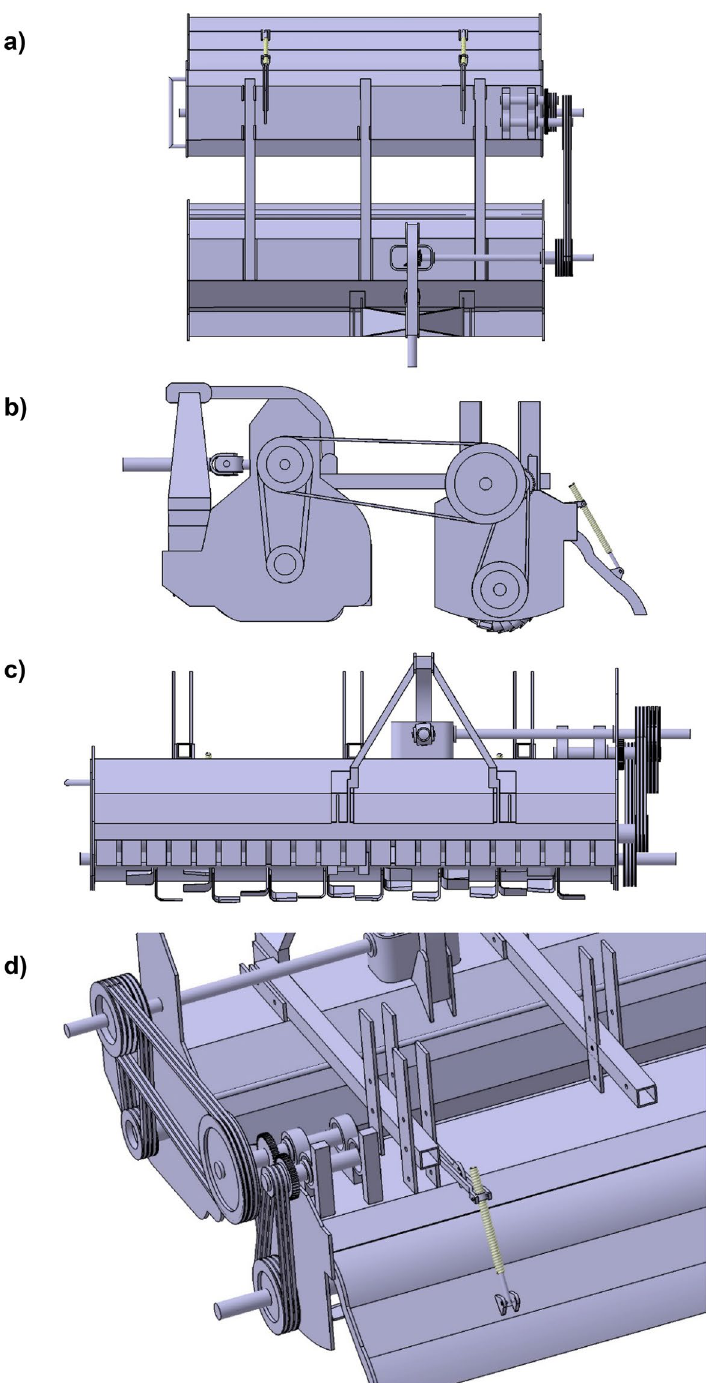
Figure 5. ( a ) Top ( b ) side, ( c ) front, and ( d ) gear views of the developed residue management